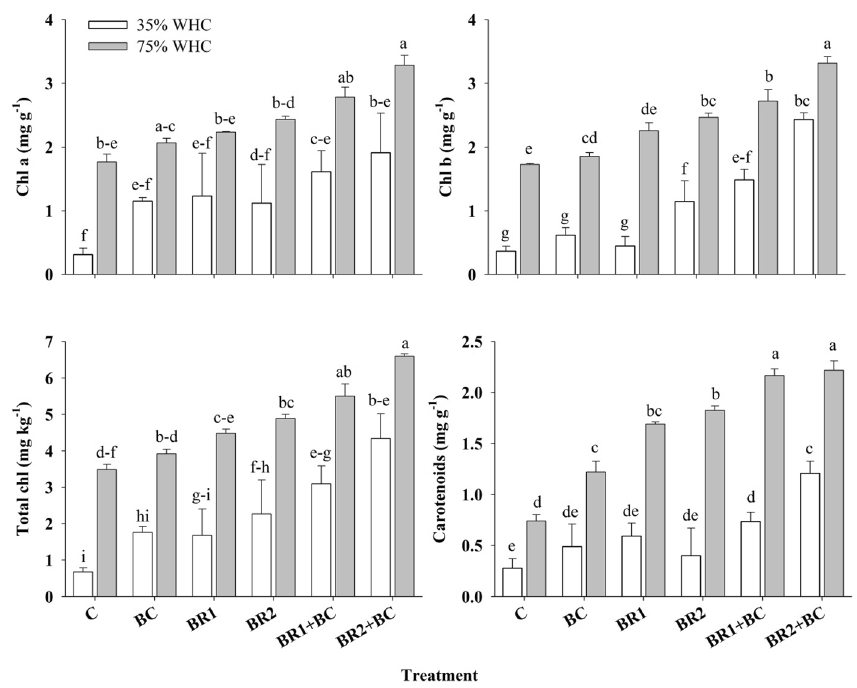
Figure 2. Role of sole and combined application of BR and BC on photosynthetic pigments contents of wheat under 35 WHC and 75 WHC. Bars show means of three replicates. Different error bars represent SD. Different letters indicate significant difference at p ≤ 0.05; LSD Test. ( 75 WHC well-watered, 35 WHC drought stress, C control, BR1 1 μmol foliar applied 24-epibrassinolide, BR2 3 μmol foliar applied 24-epibrassinolide, BC timber waste